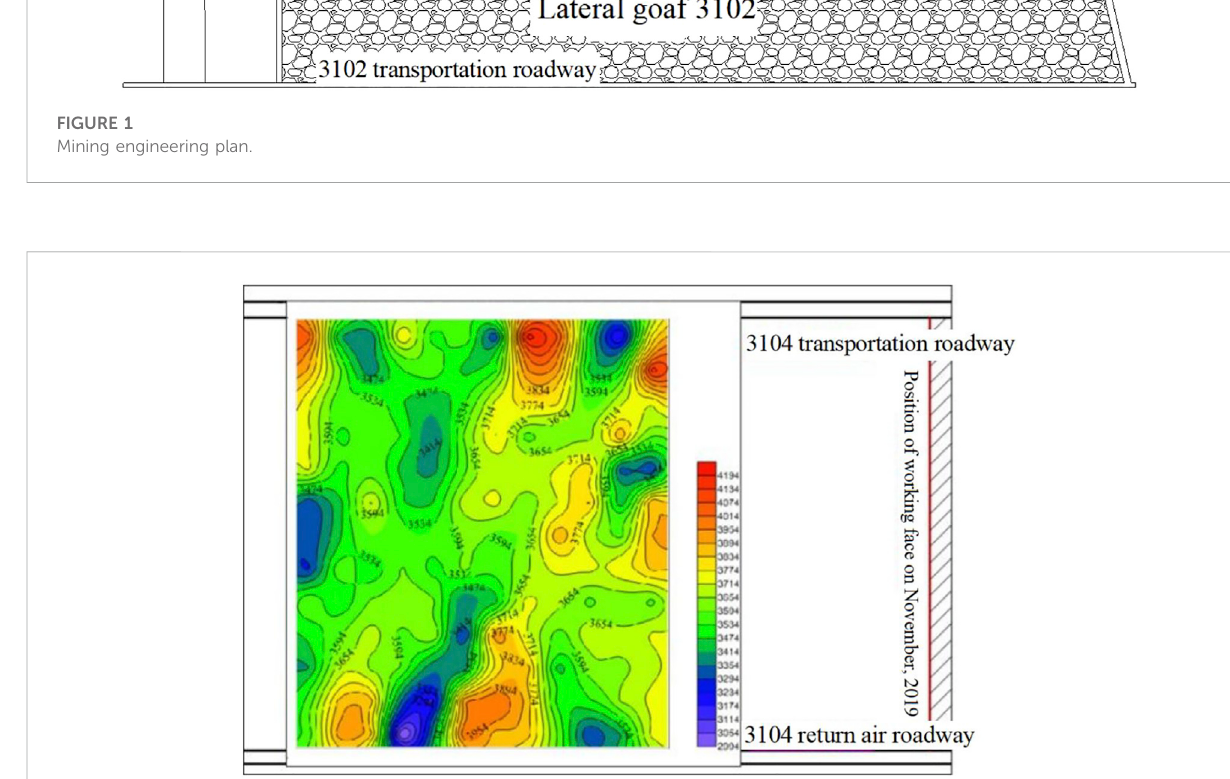
FIGURE 2 Cloud image of wave velocity distribution in the detection area